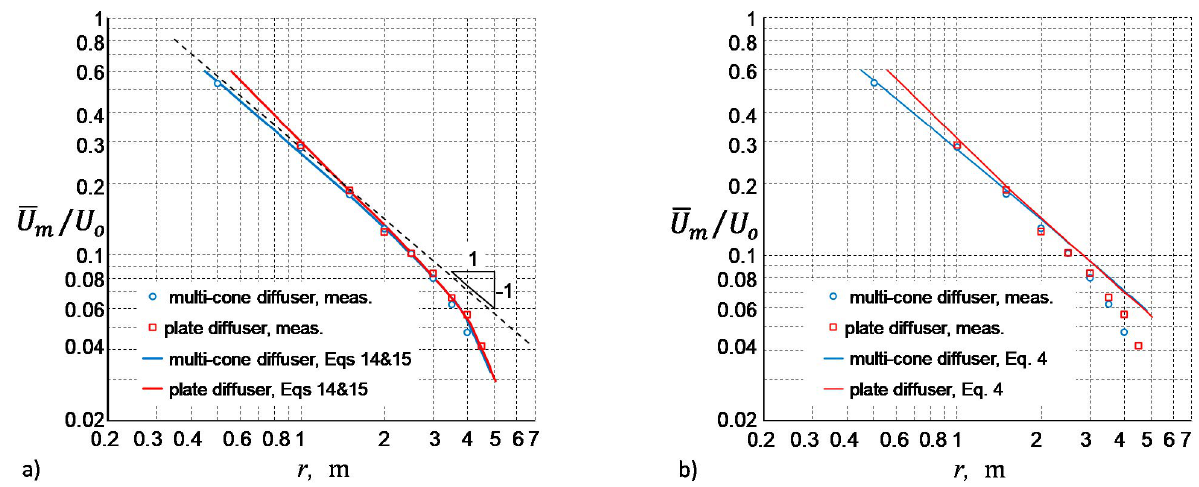
Figure 9. The decay of maximum mean air velocity with distance from the diffuser. ( a ) The results of measurement compared with the results of a calculation using Equations (14) and (15), ( b ) the results of measurement compared with the results of a calculation using Equation (4).